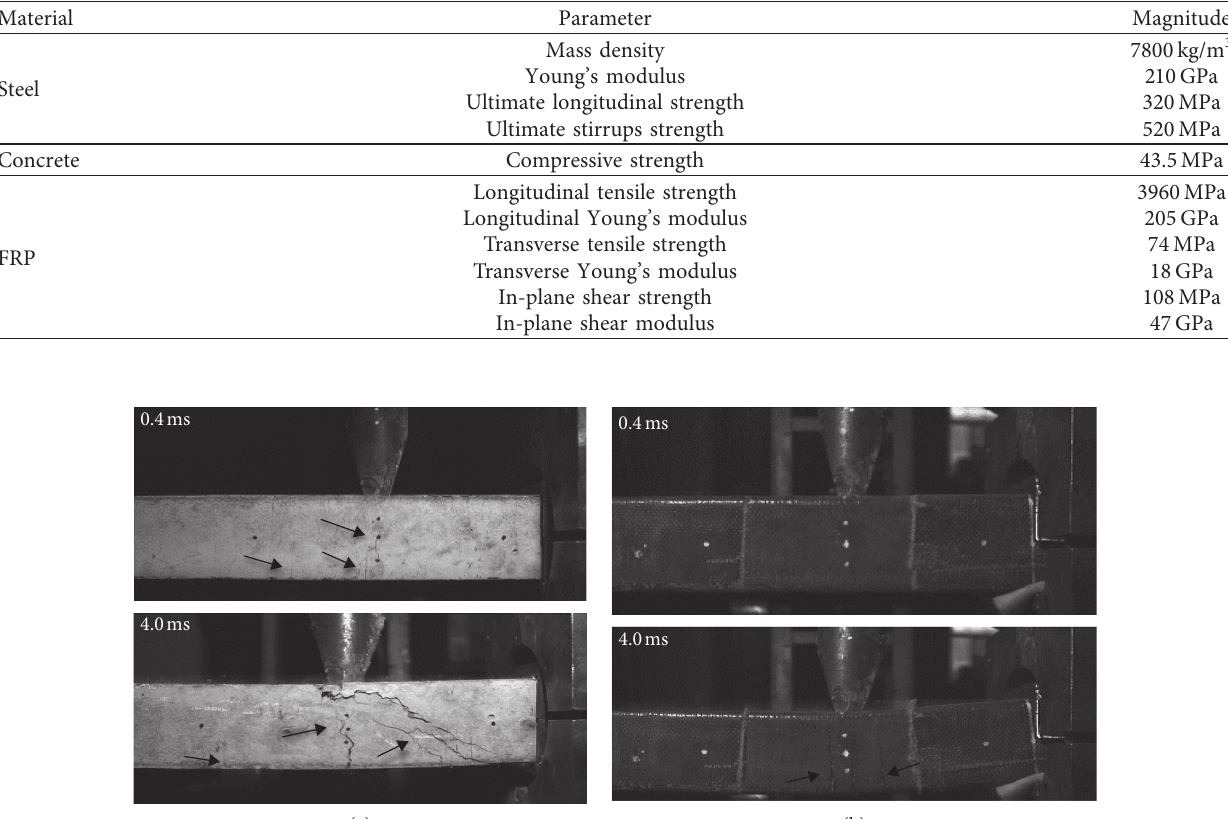
Table 1: The details of material properties.